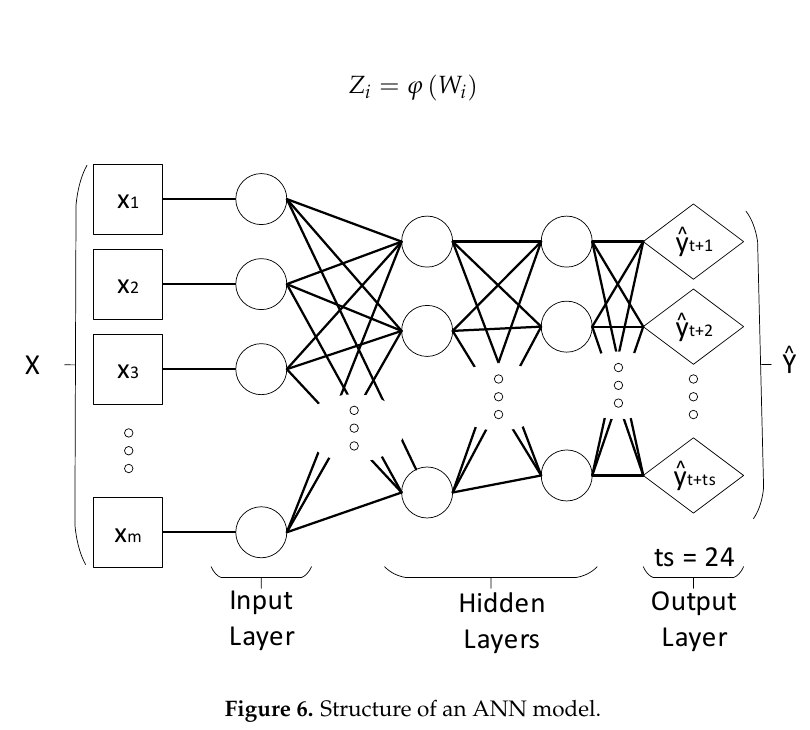
Figure 6. Structure of an ANN model.